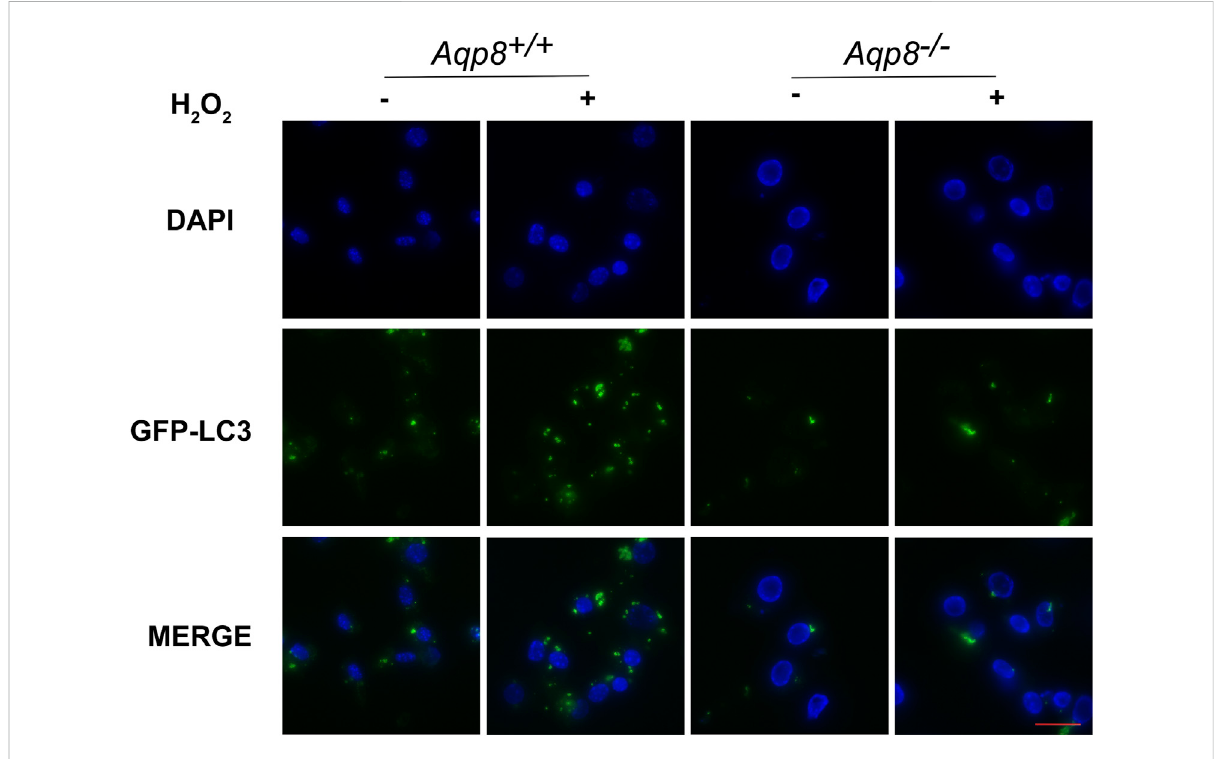
FIGURE 6 AQP8-mediated H 2 O 2 uptake in fl uences granulosa intracellular autophagy. GCs transfected with the GFP-LC3B plasmid for 24 h were incubated with 200 μ M H 2 O 2 for 1 h and rinsed in PBS. A live cell station was employed to observe the GFP fl uorescent puncta in GCs. The nuclei were counterstained with DAPI (blue). Scale bar = 10 μ